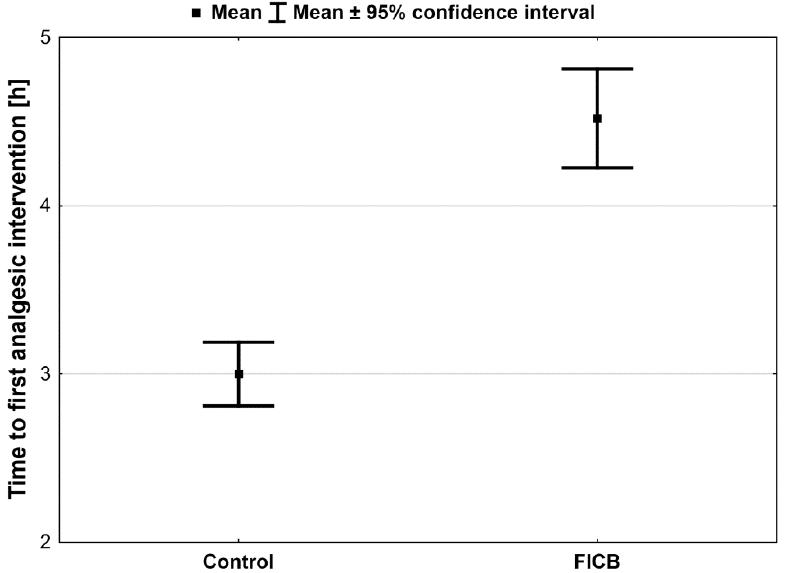
Figure 6. Time to the first analgesic intervention. Significantly longer time to the first analgesic intervention in the FICB group compared to controls.